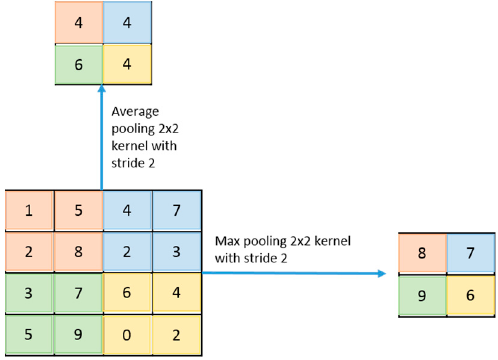
Figure 25. Average and max-pooling operations.